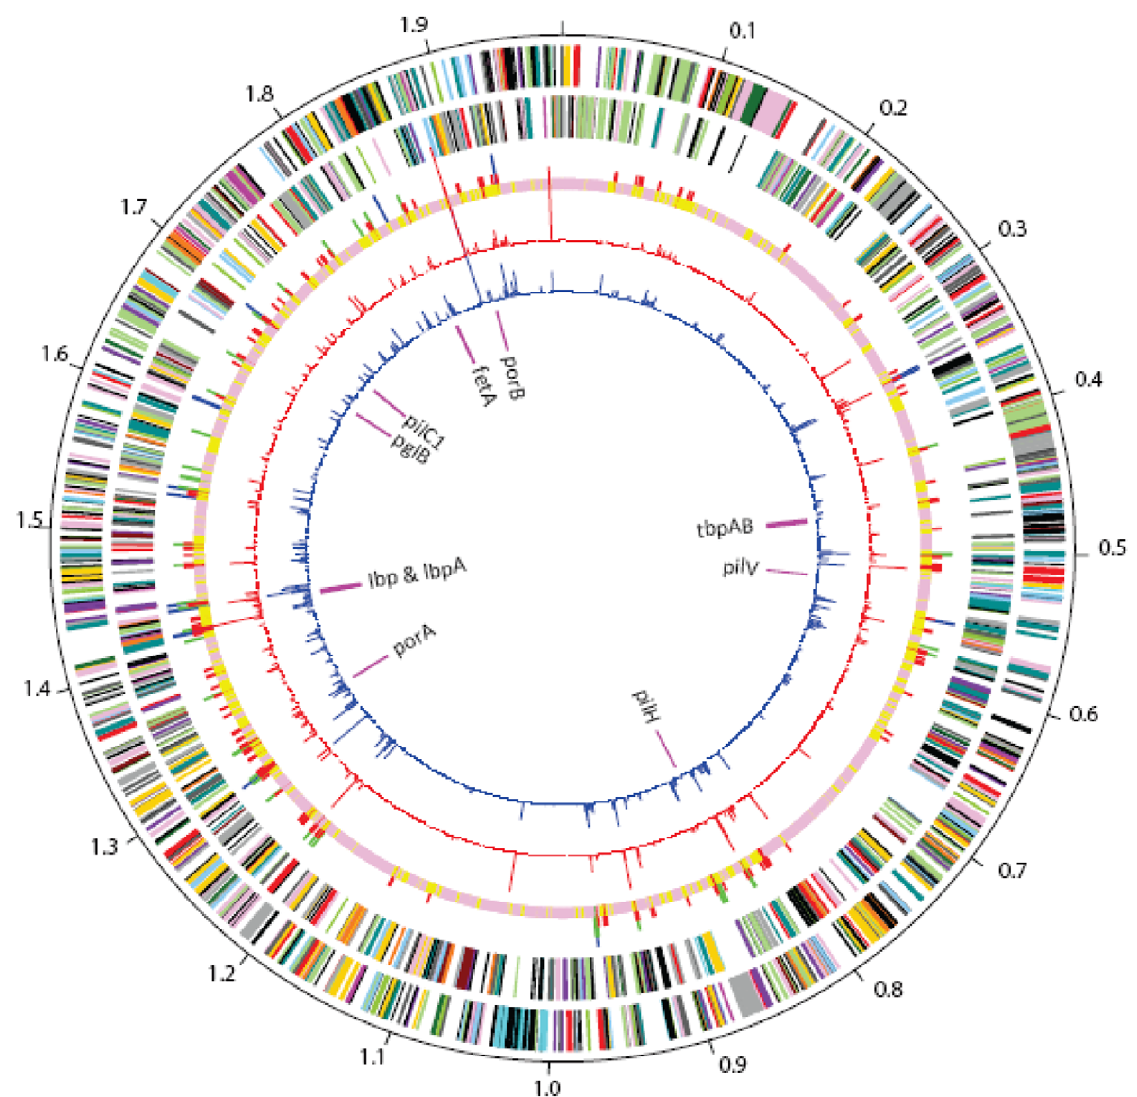
Figure 1. Circular representation of similarity of late strain type genome to early strain type genome. Ordered from outermost to innermost, the rims show: rim 1 (plus strand) and rim 2 (minus strand), predicted coding regions, colored by role category; rim 3, SNP density; rim 4, p N , plotted from 0 (base of rim) to 0.1; rim 5, p S , plotted 0 (base of rim) to 0.5. Role category colors are: amino acid biosynthesis, violet; biosynthesis of cofactors, prosthetic groups and carriers, light blue; cell envelope, light green; cellular processes, red; central intermediary metabolism, brown; disrupted reading frame, black; DNA metabolism, gold; energy metabolism, light gray; fatty acid and phospholipid metabolism, magenta; hypothetical proteins, black; mobile and extrachromosomal element functions, cyan; protein fate, pink; protein synthesis, pink; purines, pyrimidines, nucleosides and nucleotides, orange; regulatory functions, olive; signal transduction, olive; transcription, dark green; transport and binding proteins, blue-green; unknown function, gray; viral functions, gray. SNP density: pink, 0 SNPs per kbp; yellow, 1–25 SNPs per kbp; red, 26–50 SNPs per kbp; green, 51–75 SNPs per kbp; blue, 76–155 SNPs per kbp.